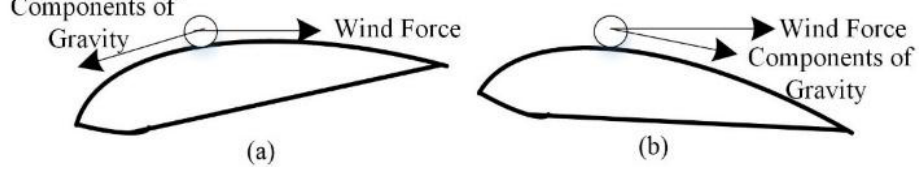
Figure 6. Force analysis for droplets on blade surfaces, ( a ) AOA = −10°, ( b ) AOA = +10°.